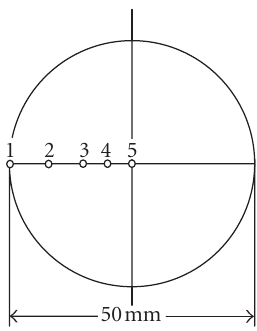
Figure 2.1 . Locations of hardness tests at di ff erent radii of the work material